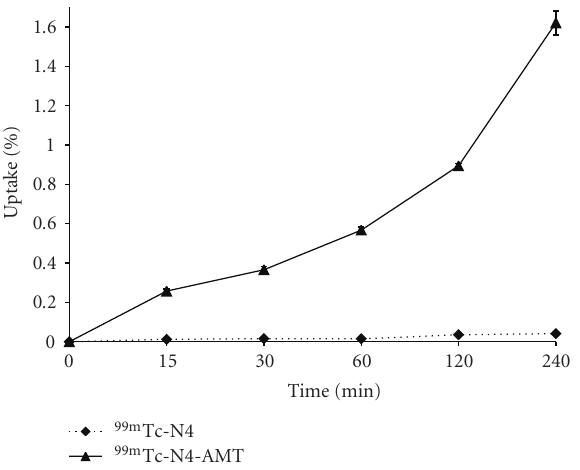
Figure 3: In vitro cellular uptake of 99m Tc-N4-AMT. The cellular uptake kinetics of 99m Tc-N4-AMT and 99m Tc-N4 was conducted in the rat breast tumor cell line 13762. Data were expressed in mean ± S.D. percent of cellular uptake